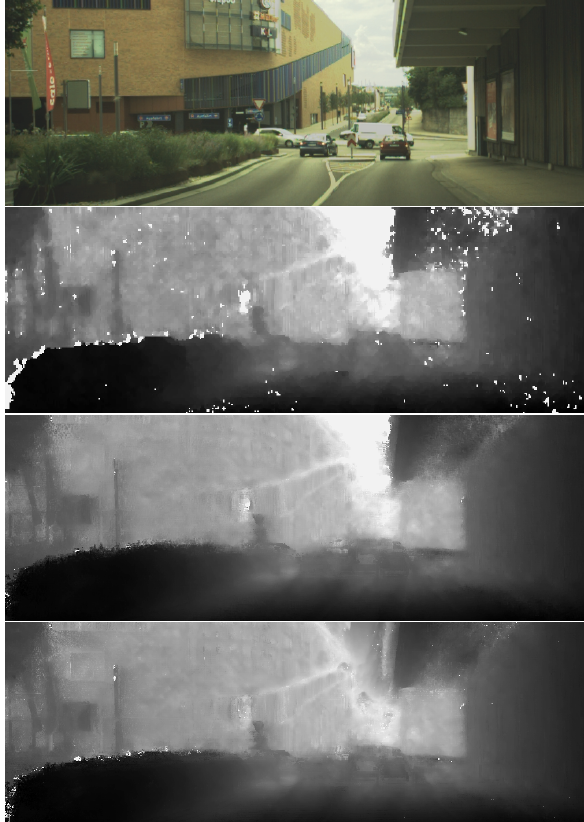
Figure 5. Picture detail of traffic scene. See fig. 3 for parameter description. Note the poles and flags on the left hand